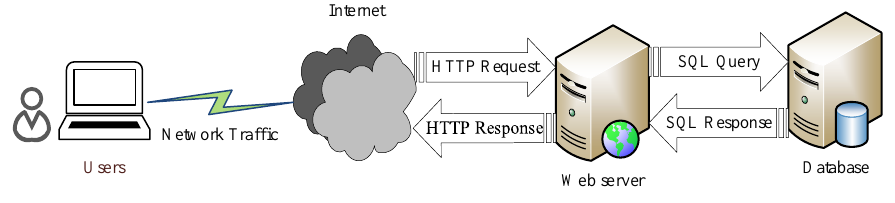
Figure 1. How SQL injection attacks